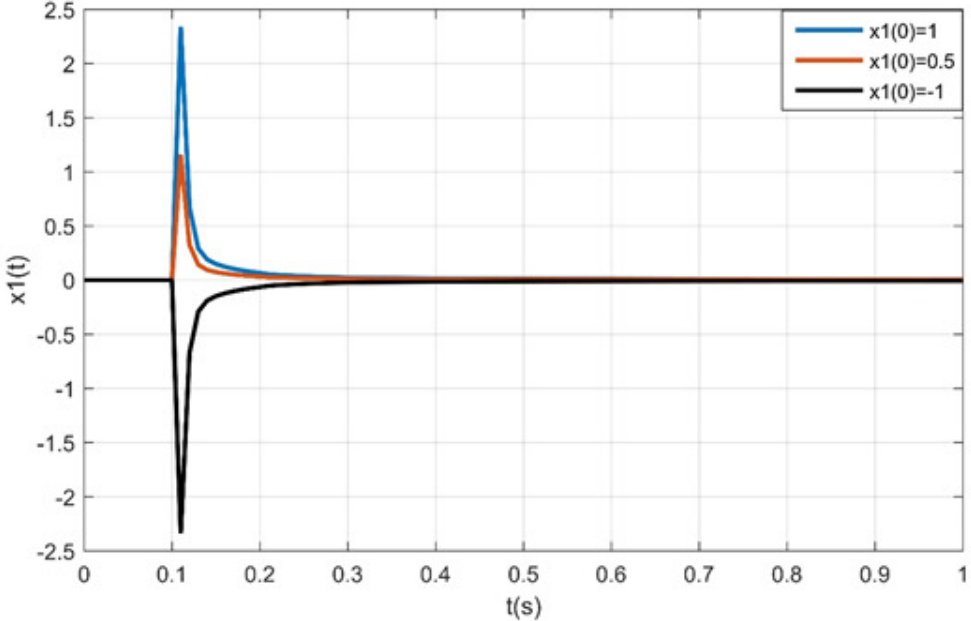
Figure 7. The boundedness of solution x 1 ( t ) of the system of IFrRDEs in Equation (13) for q = 0.9, τ = 1 , ρ = 1 and different initial values when t ≥ 1 5 10